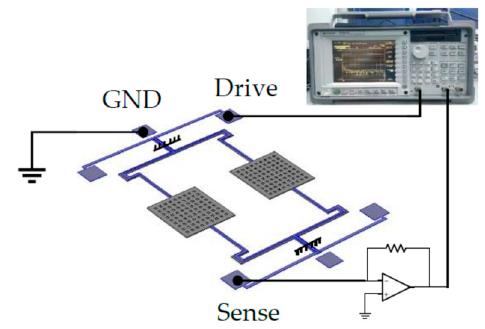
Figure 7. The schematics of the electrical test.